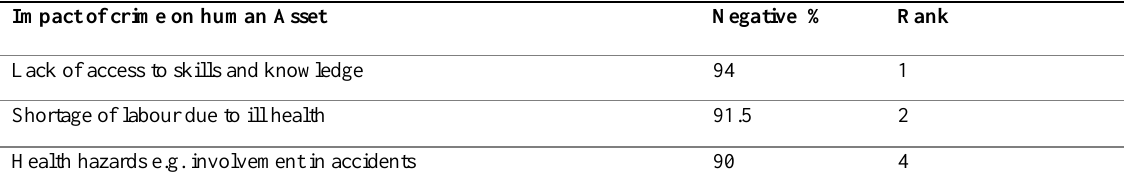
Table 3 : Impact of crime on human Asset